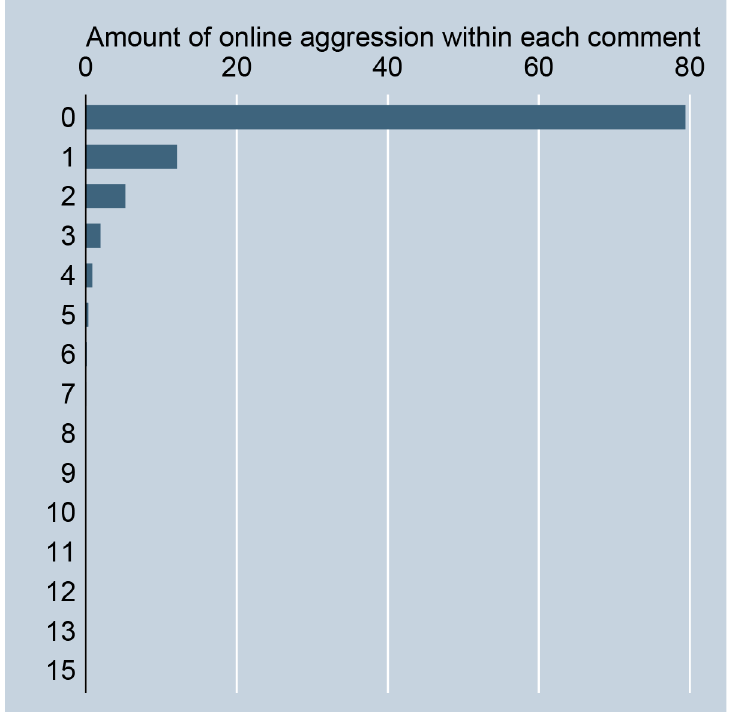
Fig 1. Observed amount of online aggression per